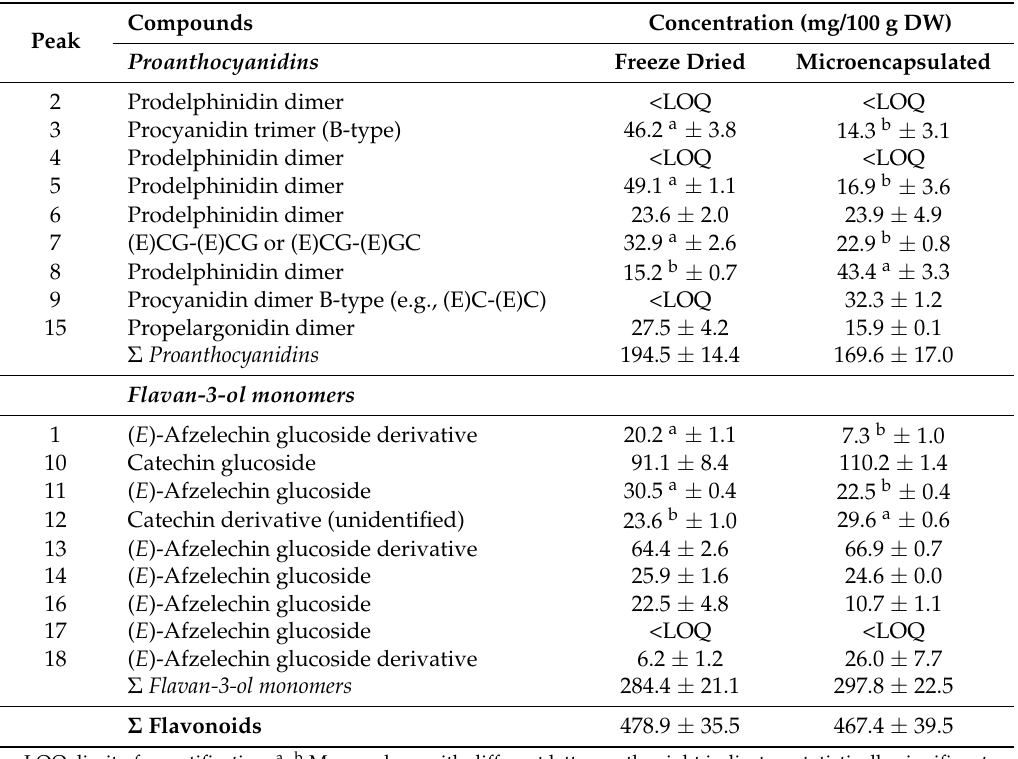
Table 2. Flavonoid composition in freeze dried and microencapsulated banana passion fruit